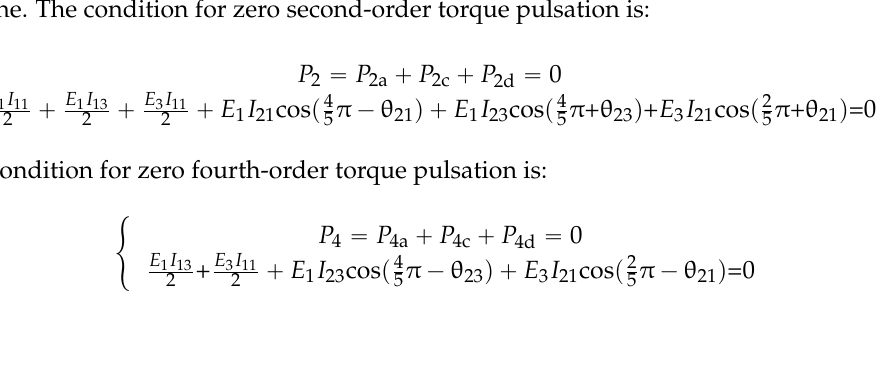
Table 2. The optimum solutions to the fault ‐ tolerant currents under non ‐ adjacent double ‐ phase open ‐ circuit fault types.